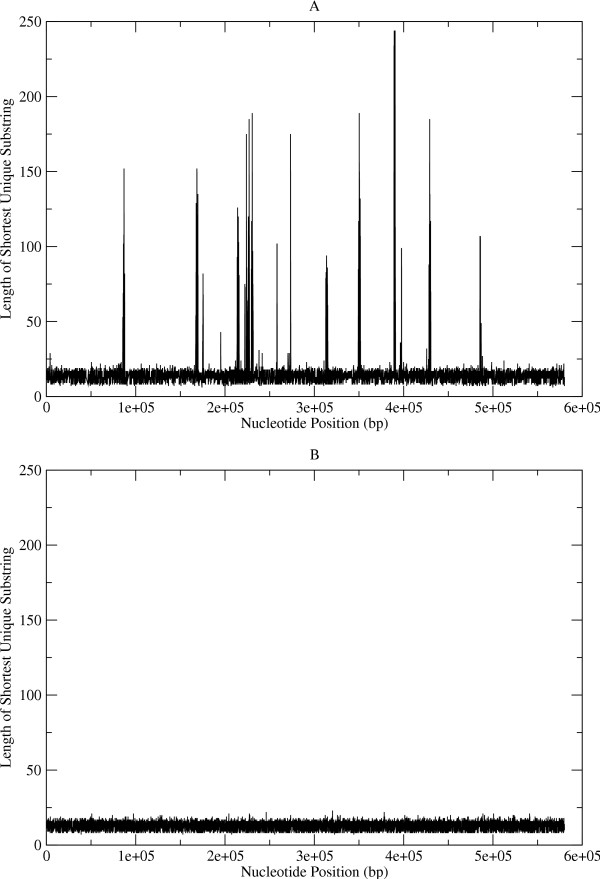
Shustrings in Mycoplasma genitalium. A: Lengths of the local shortest unique substrings at every position along the genome of Mycoplasma genitalium. The lengths displayed minus one correspond to the lengths of substrings which are repeated at least once in the genome. B: The same as A, except that the nucleotides in the genome were shuffled (thus preserving nucleotide frequencies), which leads to the disappearance of long repeats.